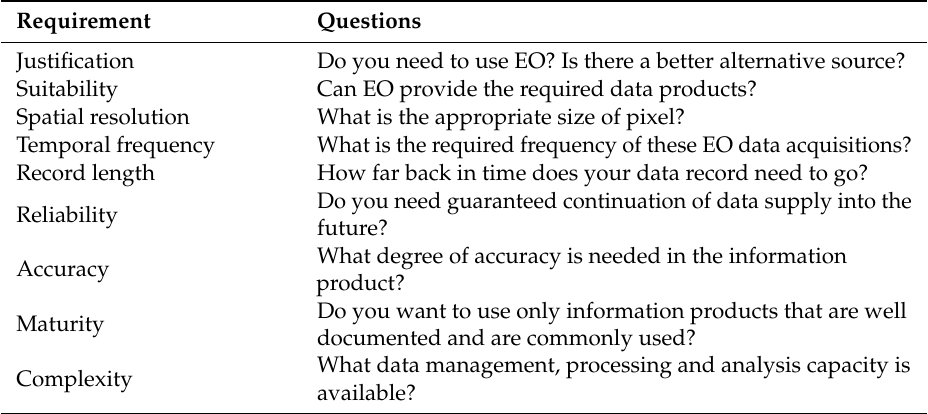
Table 11. Requirement of the use of EO for o ffi cial statistics